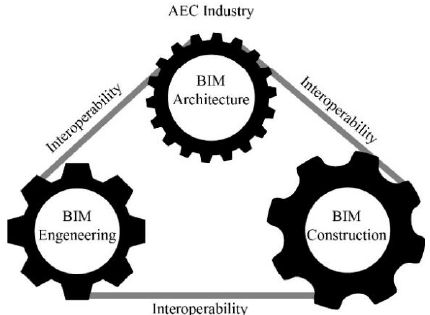
Figure 1. The interoperability bonds together the AEC industry’s